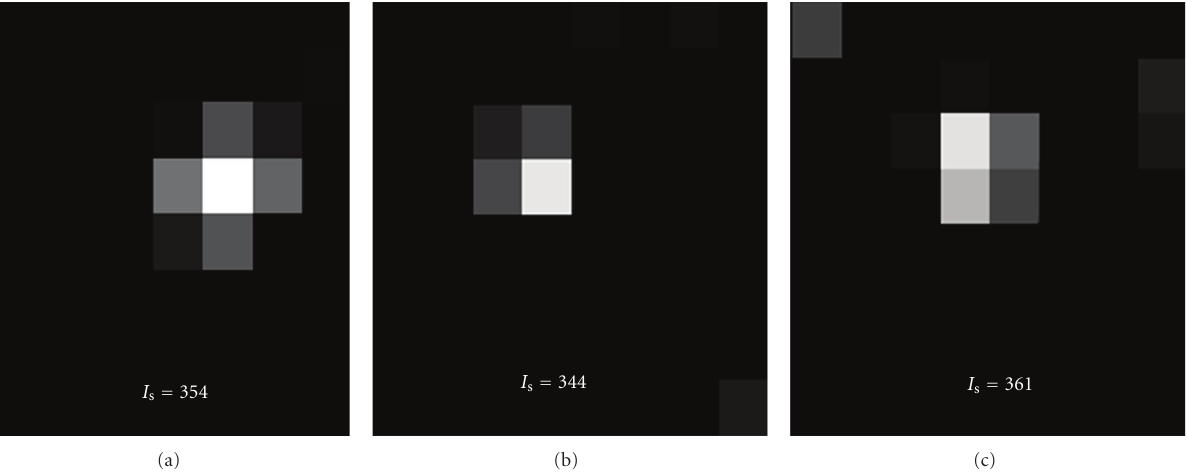
Figure 1: The appearance of single cells/microspheres is distorted by pixelation. The shape greatly depends upon the location of the microsphere with respect to the sampling grid of the CCD camera. Three separate single microspheres in OCT are shown with their corresponding integrated intensity. Although the images appear much di ff erent, the integrated intensity is nearly equal and within the 5% variation specified by the manufacturer.